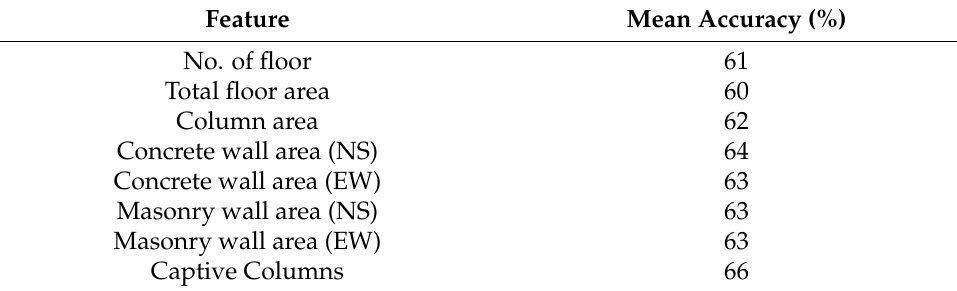
Figure 18. Haiti: Boxplot to represent the mean accuracy distribution achieved by hyper-tuning the input features. Table 7. Haiti: Predictive accuracy score against each input